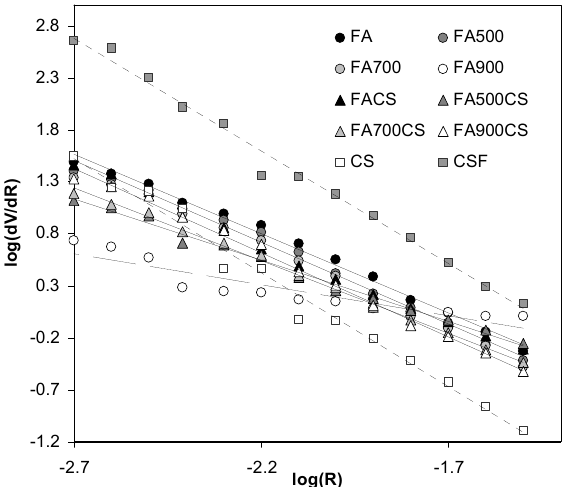
Figure 5. Pore surface fractal plots for the studied sorbents. The linearity ranges detected for all adsorbents are in the range of very fine pores. Numerical values of mesopore parameters of the studied adsorbents derived from mercury intrusion curves are summarized in Table 2. Table 2. Mesopore parameters of the studied adsorbents. V mesopore volume, R average mesopore radius, PT penetration threshold, V ia intra-aggregate pore volume, D s mesopore surface “fractal dimension”. parameter